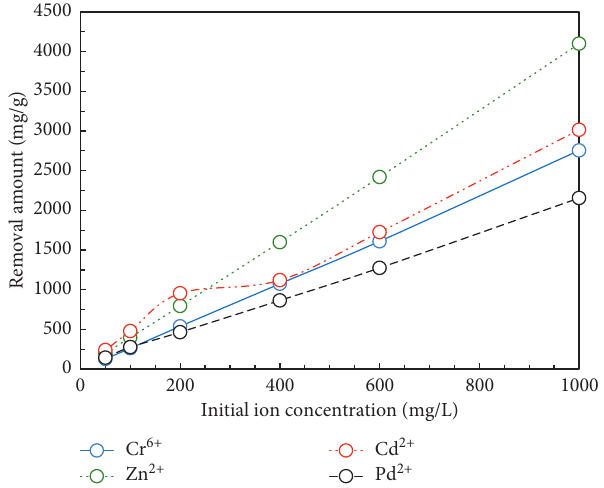
Figure 8: Removal amount (mg/g) relative to the initial ion concentration of Cr(VI), Pd(II), Cd(II), and